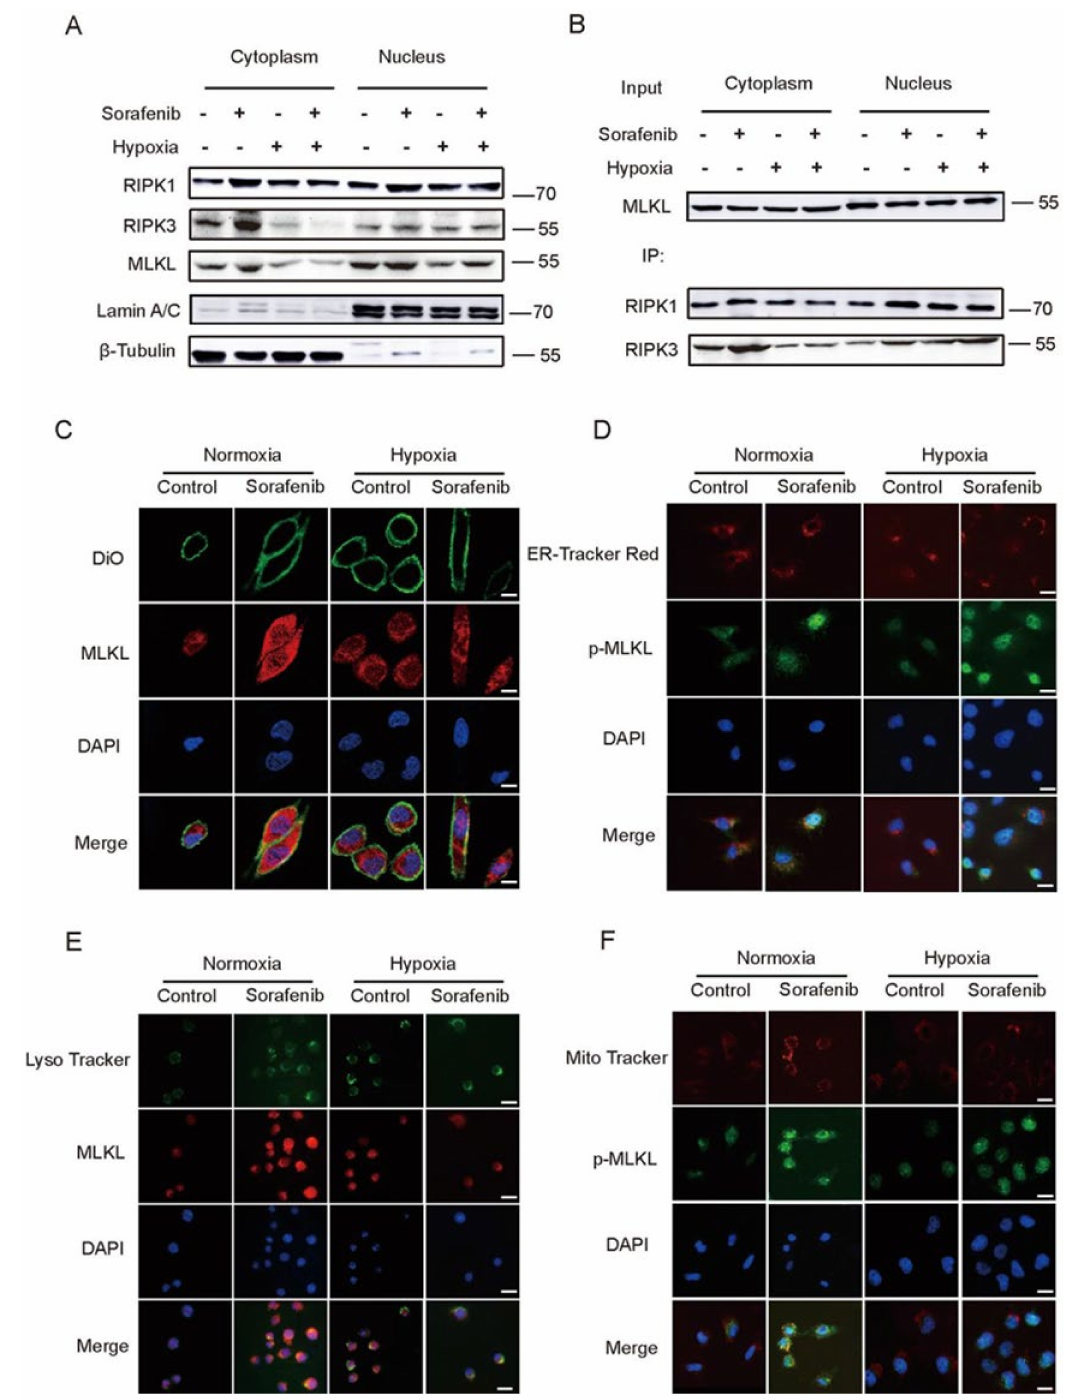
Figure 3. Hypoxia Impeded the Distribution of RIPK1/RIPK3/MLKL Complex in Cytoplasm. ( A ) Distribution of necropto- sis proteins in cytoplasmic and nuclear observed by WB. ( B ) Distribution of RIPK1/RIPK3/MLKL complex in cytoplasm by Co-IP. ( C – F ) Expression of MLKL on different organelles, which has a rich membrane structure such as a cell mem- brane, mitochondria, endoplasmic reticulum, and lysosome observed by immunofluorescence. ( C ): Scale bar = 80 µ m. ( D – F ): Scale bar = 40 µ